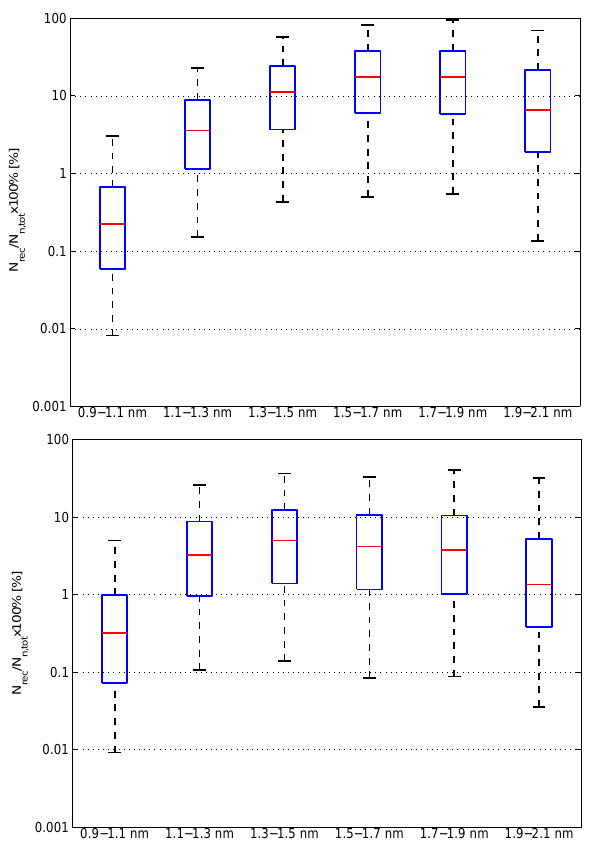
Fig. 6. The percentage of recombination products of all neutral clus- ters in different size classes (top) when assuming that the cluster growth rate increases more slowly with the increasing size than shown by experimental data (bottom) when the effect of conden- sational growth is neglected and the coefficient λ is not assumed to equal 1. The red lines show the medians, the blue boxes indicate the 25th and 75th percentiles, and the vertical bars show the 5th and 95th